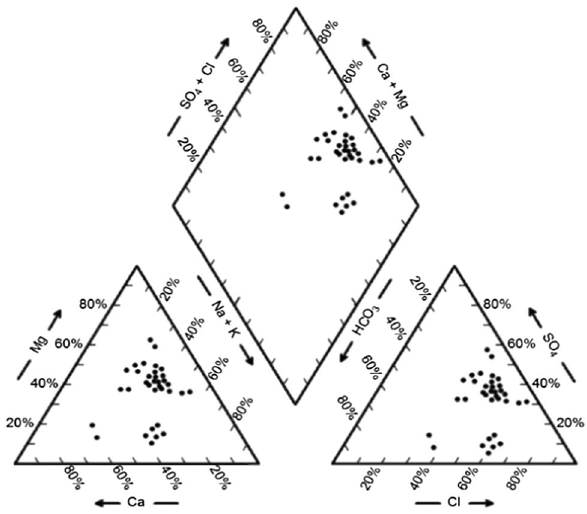
Fig. 5 Chemical facies of groundwater in Piper diagram